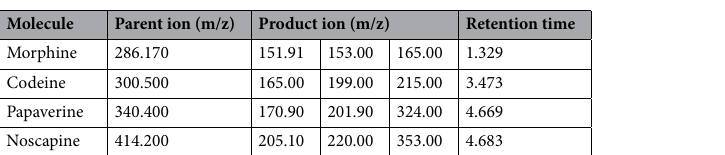
Table 3. Identification criteria for molecules under